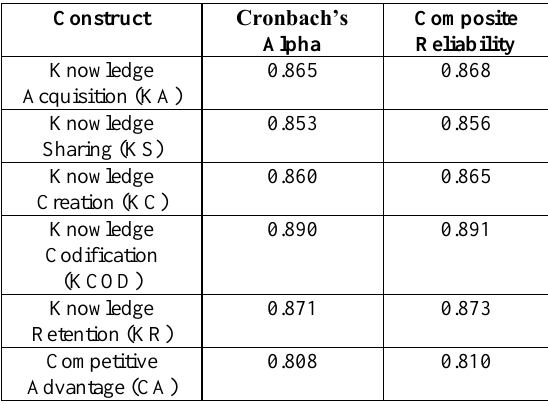
Table 4: Cronbach’s Alpha and CR Test for